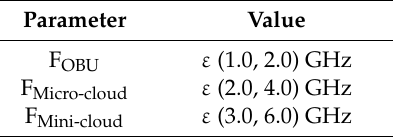
Table 6. Simulation parameters for evaluating offloading algorithm.